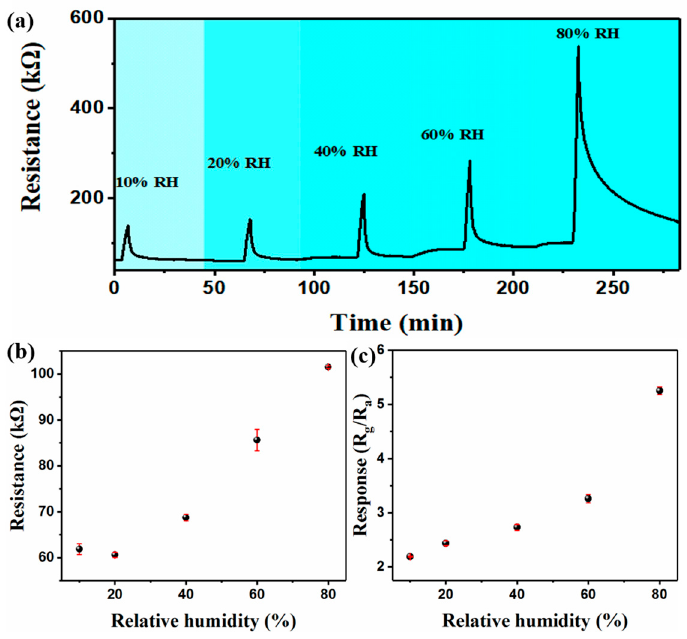
Figure 5. Sensing transients ( a ), initial resistance ( b ) and the response ( c ) of PM2 sensor to 1 ppm NH 3 in humid environment.